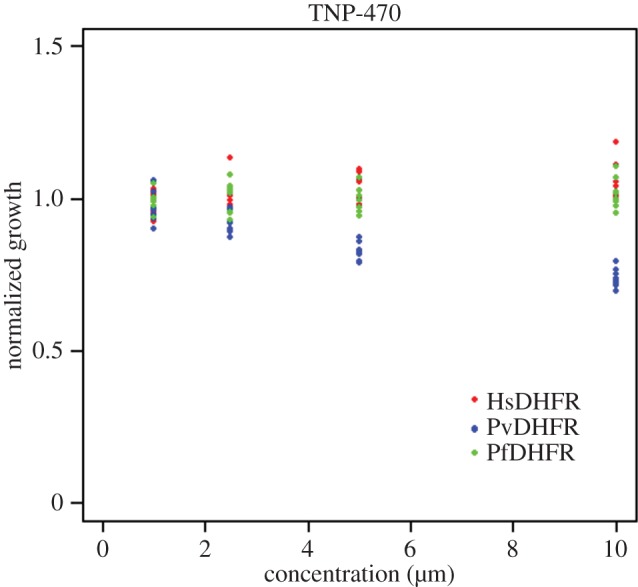
An Eve hit-confirmation run with four replicates. TNP-470 dose response curves for: yHsDHFRp (red), yPfDHFRp (green) and yPvDHFRp (blue). Normalized growth is calculated by comparison to in-plate negative controls.